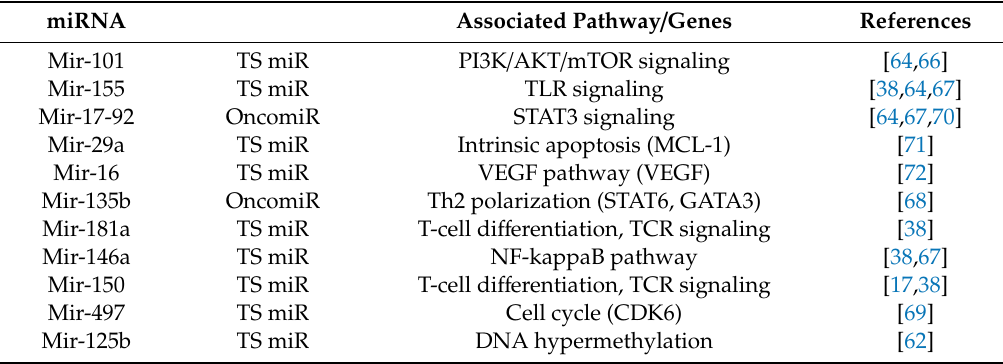
Table 1. Overview of miRNAs in ALCL. The previously discussed miRNAs with a ff ected pathways are mentioned, along with whether they have a tumor suppressive (TS) or oncogenic (OncomiR) function in ALK-positive ALCL. PI3K, phosphoinositide 3-kinase; AKT, RAC-alpha serine / threonine-protein kinase; mTOR, mammalian target of rapamycin; TLR, toll-like receptor; STAT3, signal transducer and activator of transcription 3; MCL-1, myeloid cell leukemia; VEGF, vascular endothelial growth factor; STAT6, signal transducer and activator of transcription 6; GATA3, GATA binding protein 3; TCR, T-cell receptor; NF-kappaB, nuclear factor ‘kappa-light-chain-enhancer’ of activated B-cells; CDK6, cyclin-dependent kinase 6; DNA, desoxyribonucleic acid. miRNA Associated Pathway /